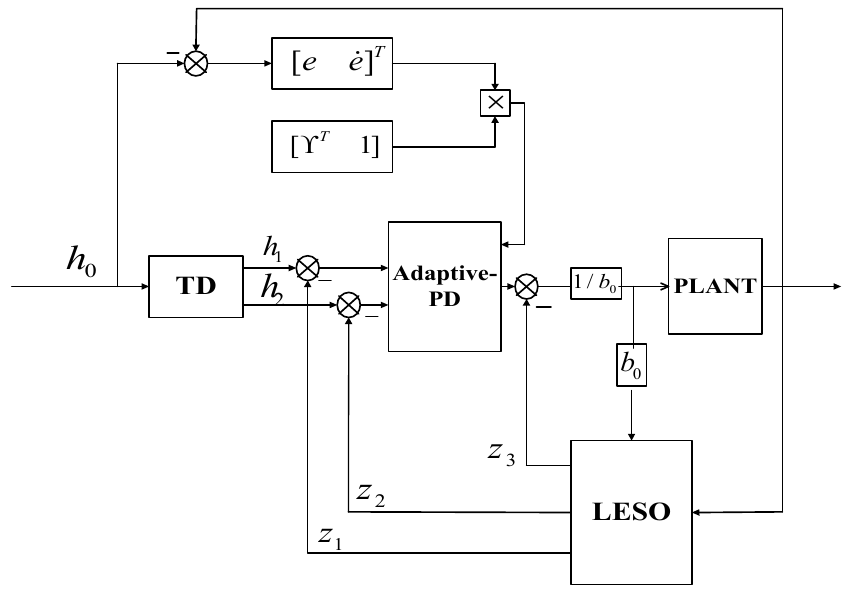
Figure 3. Structure diagram of A–LADRC controller.